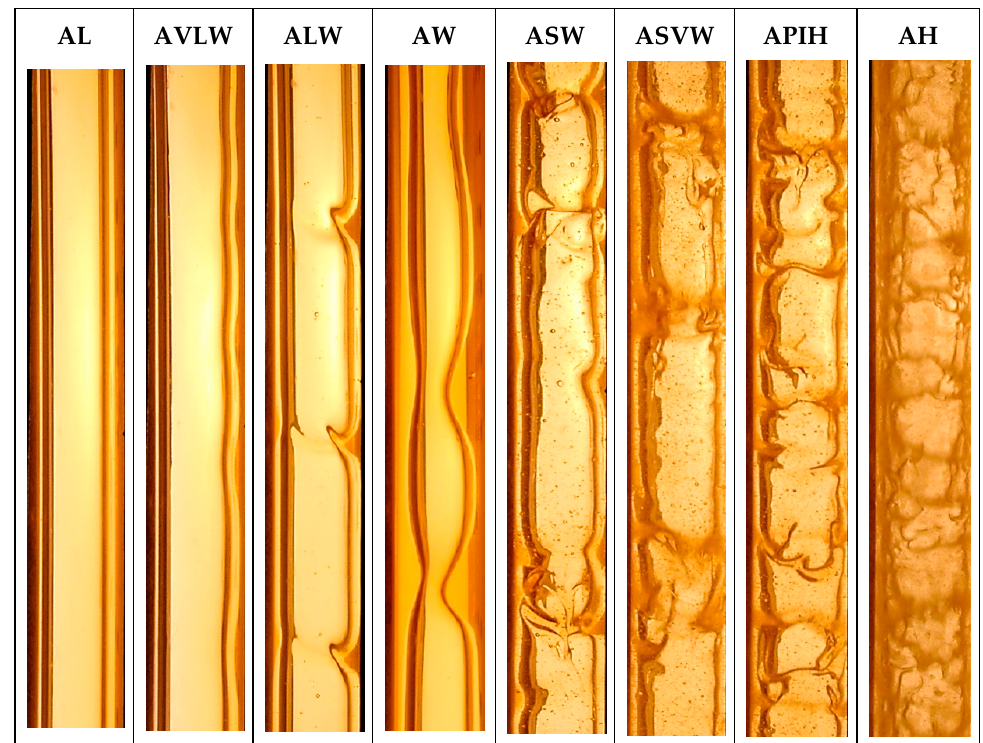
Figure 3. Flow patterns accompanying downward co-current gas–very viscous liquid flow. AL, smooth film; AVLW, film with very light waves; ALW, film with light waves; AW, wavy film; ASW, very wavy film; AVSW, strong wavy film; APIH, transient hydraulic flow; AH, hydraulic film.